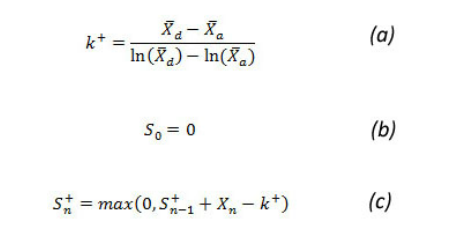
Figure 6. Poisson cumulative sum (CUSUM) equations. k = reference value, S n = CUSUM score, X n = number of cases in current time interval, X-bar a = null hypotheses mean, X-bar d = alternative hypotheses mean, + superscript refers to values always being positive.